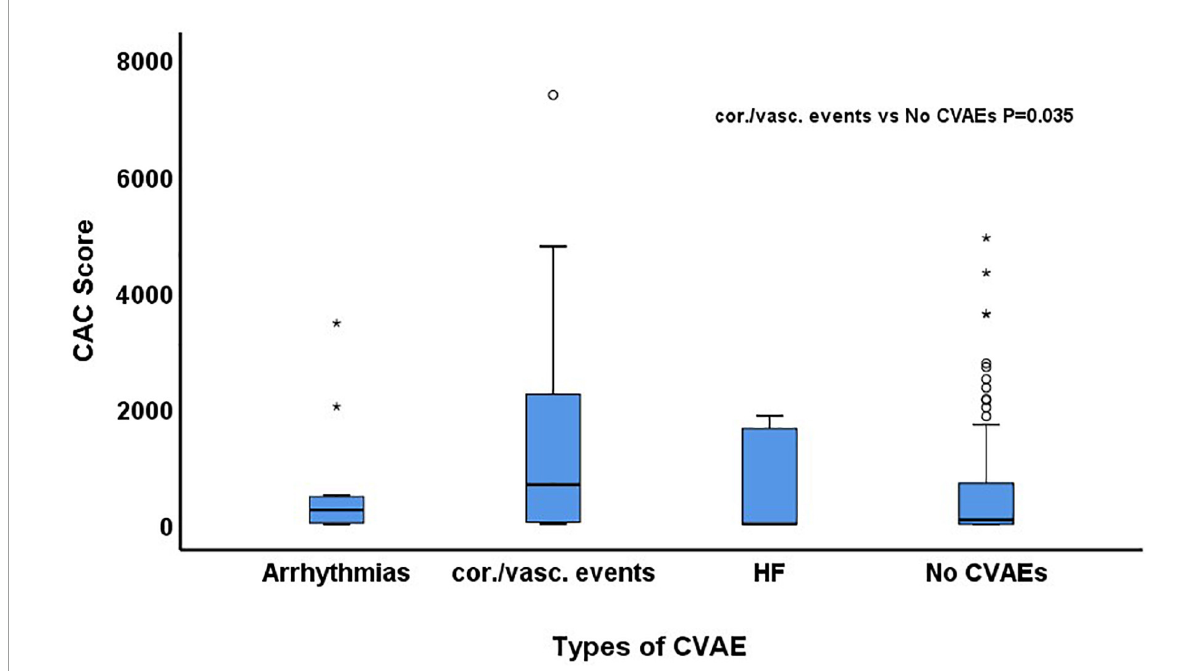
FIGURE2 Comparison of baseline coronary artery calcium (CAC) score among patients who developed arrhythmias, coronary/vascular (cor./vasc.) events and heart failure (HF) and those who did not develop any cardiovascular adverse event